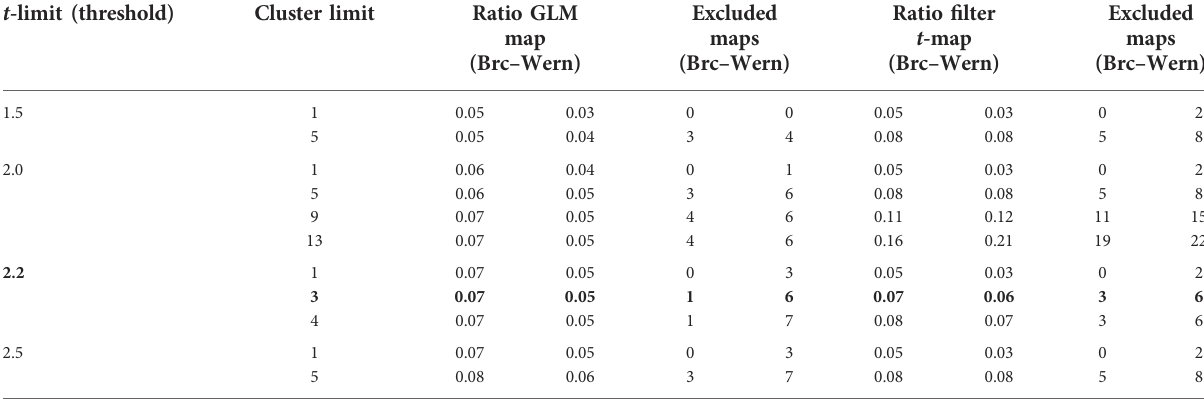
TABLE 4 Ratio of activated voxels in the language areas to all activated voxels on the map. Different t -limits and cluster limits were applied to show differences in the ratio. In addition, the number of maps that were excluded due to non-existing language activations is indicated. Fifty-two activation maps from both patients and subjects were